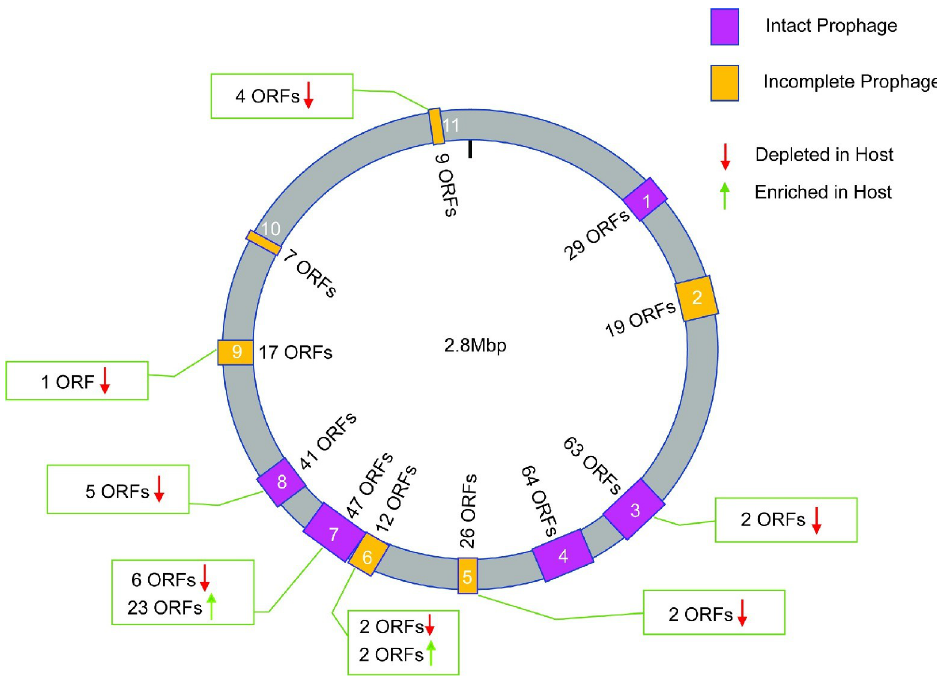
Fig 5. Identification of host essential candidate genes within putative prophage regions. PHASTER annotation of the N . musculi genome identified 11 regions associated with phage or phage like elements. Purple boxes indicate intact prophage regions while orange boxes indicate incomplete prophage regions as designated by PHASTER scoring algorithms. Arrows indicate abundance of insertion mutants after host passage in comparison to the inoculum. ORFs passing significance cutoffs after analysis are listed in green boxes for each prophage